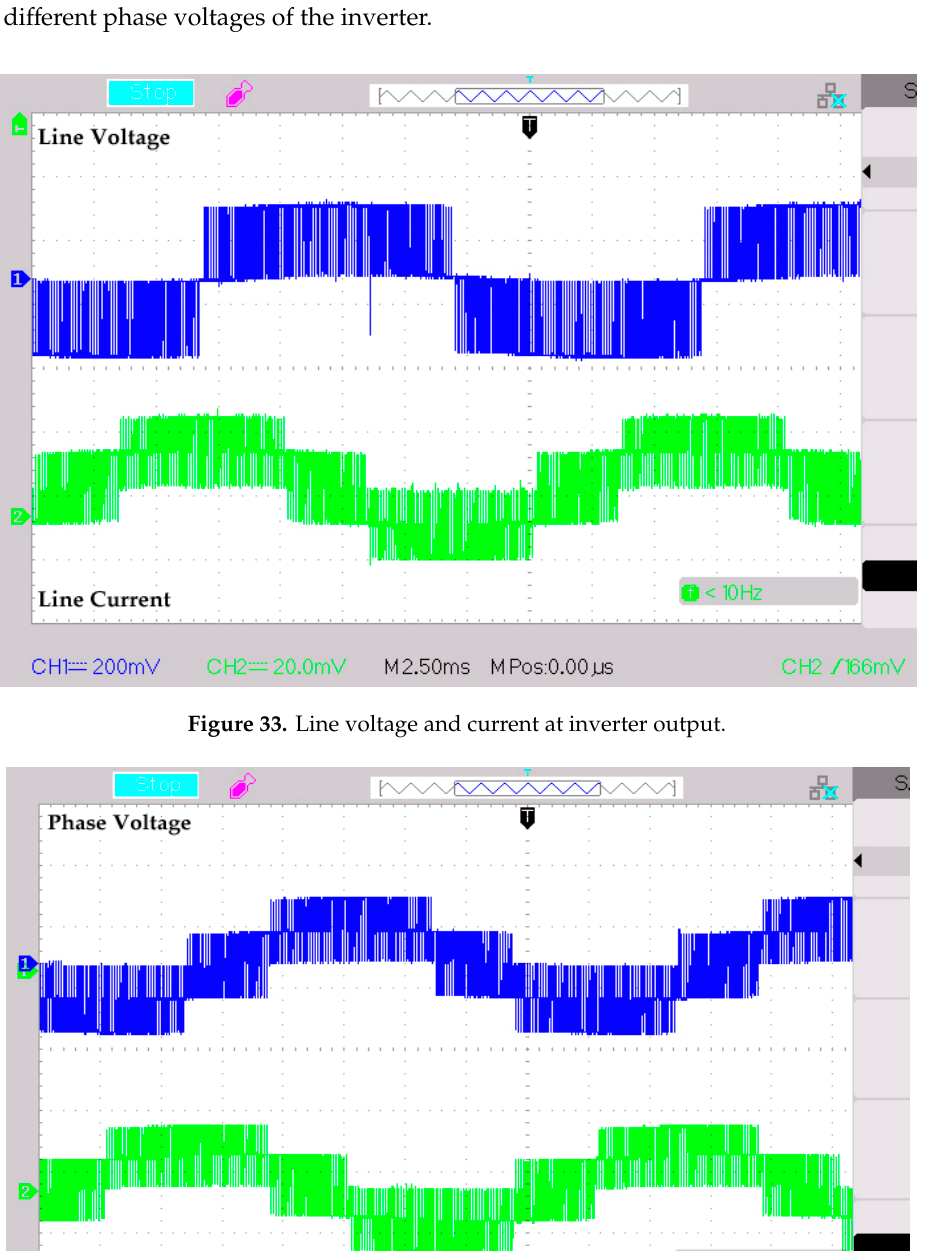
Figure 34. Phase voltages at inverter output.